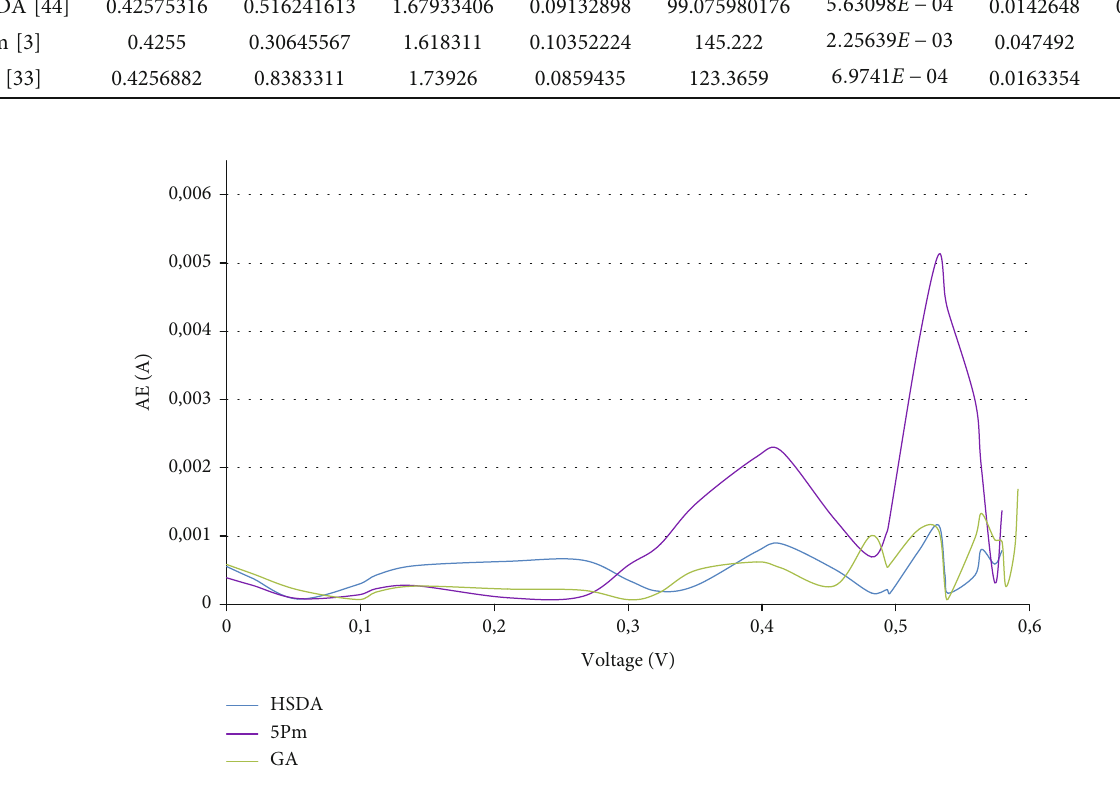
Figure 4: The absolute current error for mSi commercial photovoltaic cell. Table 5: The parameters and statistical tests for PWP201 photovoltaic